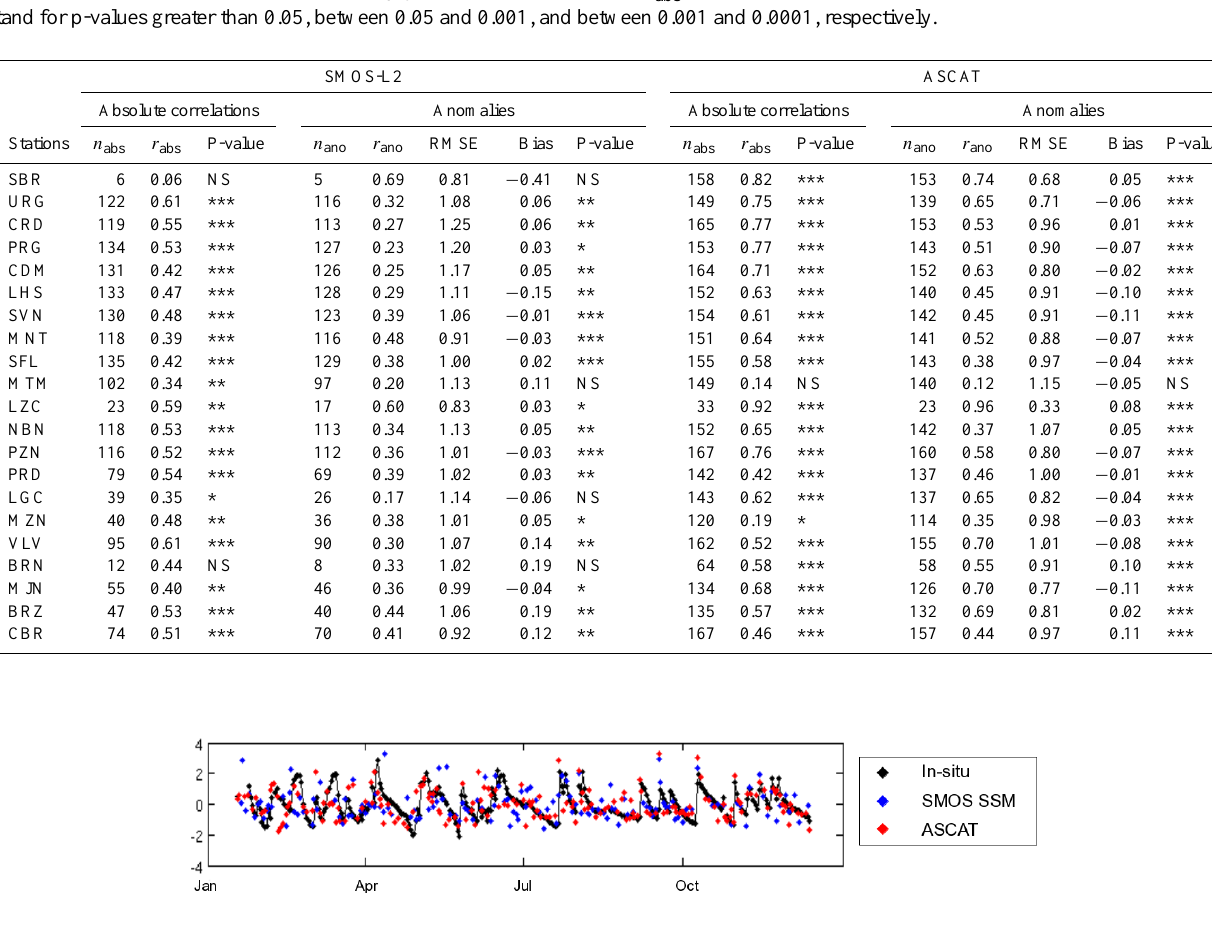
Fig. 2. Observed SSM anomalies at the Montaut (MNT) station in 2010, derived from (black) in situ measurements at a 5cm depth, (blue) SMOS-L2, (red) ASCAT.